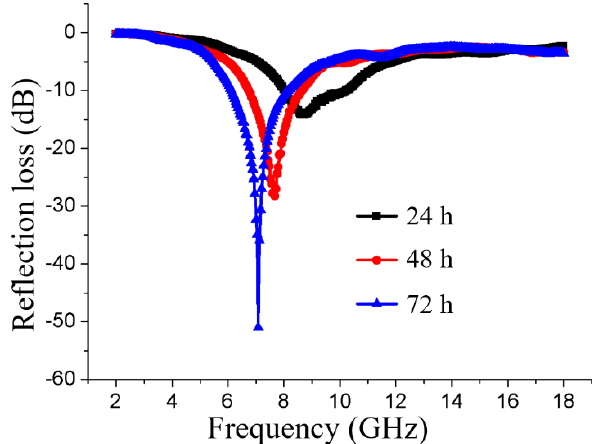
Figure 5. The reflection loss curves of the three-layer composite magnetic board fabricated by a magnetic fiber core with the thickness of 3 mm. The impregnation time was 24 h, 48 h, and 72 h, respectively.